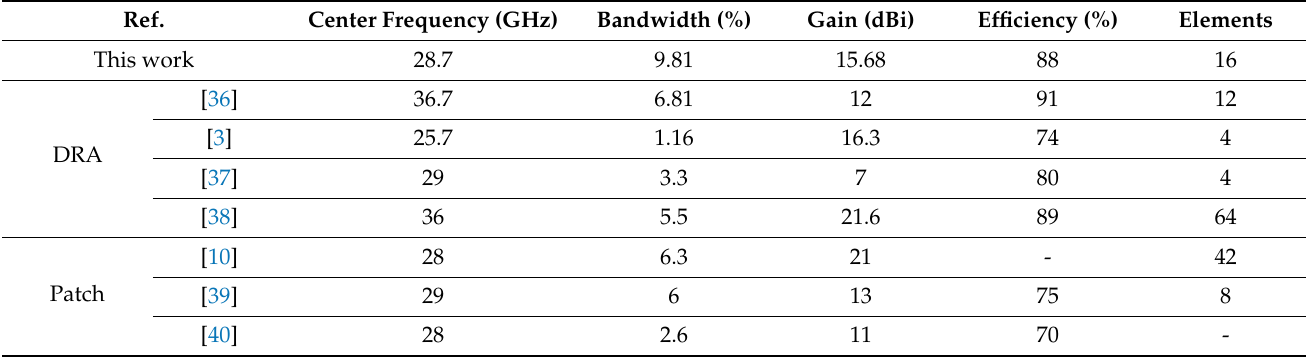
Table 2. Summary of performance of the proposed array alongside some of other reported antenna arrays in the literature.